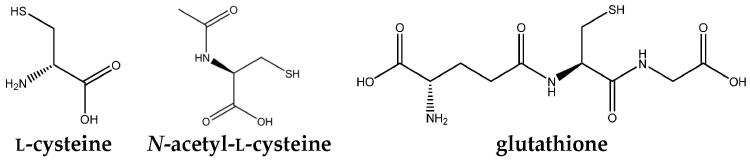
Figure 1. Chemical structures of N -acetyl- L -cysteine, L -cysteine and